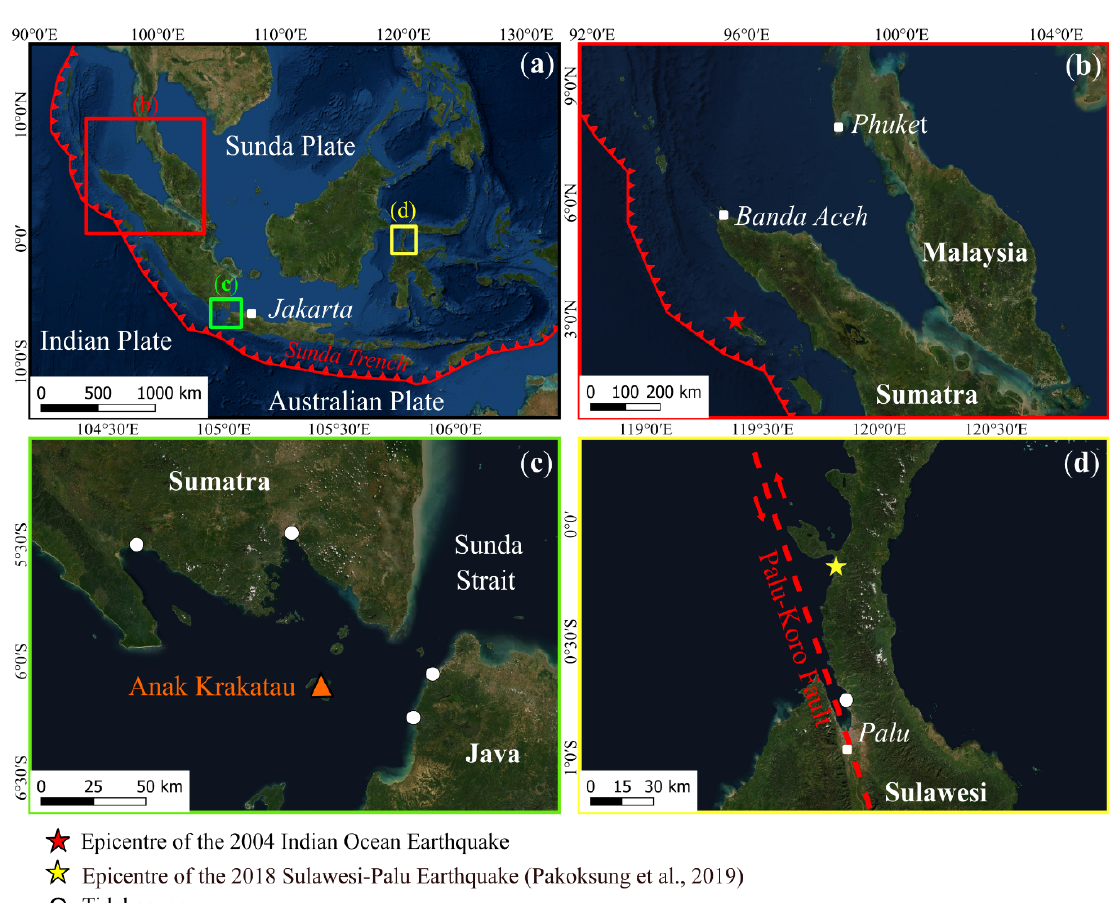
Figure 1. (a) Indonesia partially surrounded by the Sunda Trench, (b) epicentre location of the 2004 Indian Ocean earthquake, (c) location of the Sunda Strait and the Anak Krakatau volcano, and (d) epicentre location of the 2018 Sulawesi–Palu earthquake (Pakoksung et al., 2019) and the Palu-Koro fault crossing Palu Bay, on Sulawesi Island, Indonesia (background